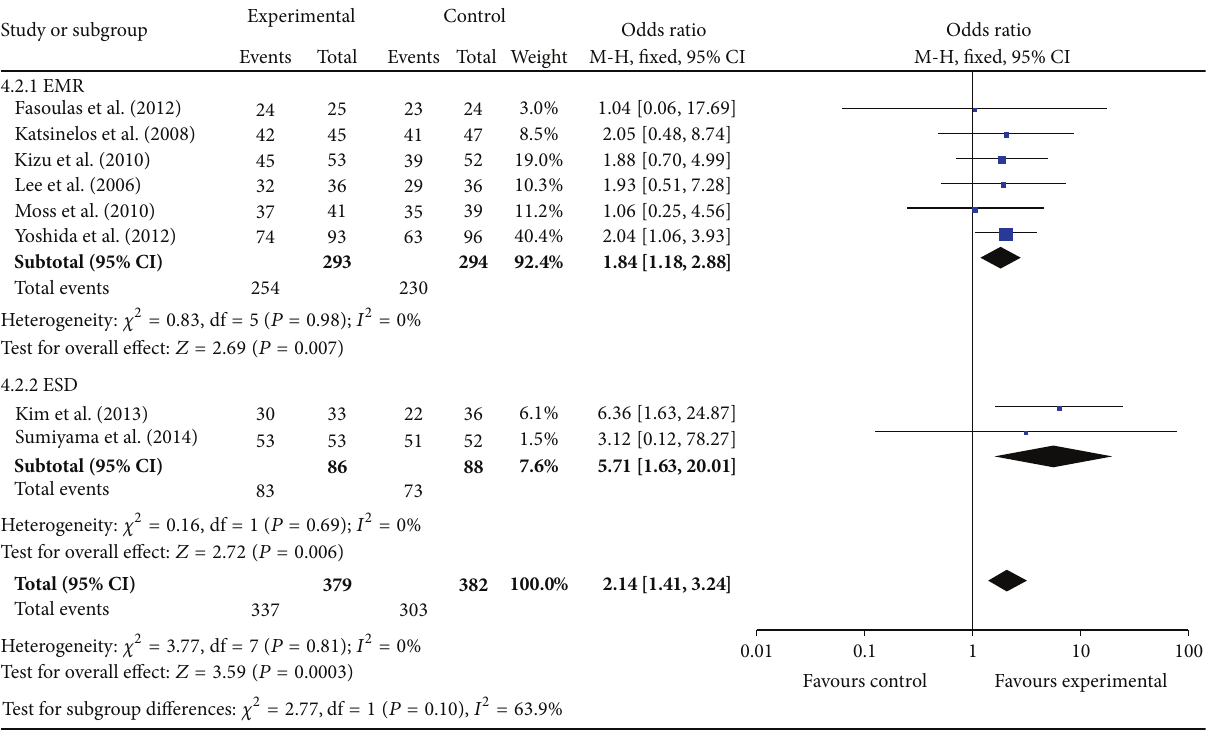
Figure 4: Meta-analysis results of complete resection rate between the two groups.